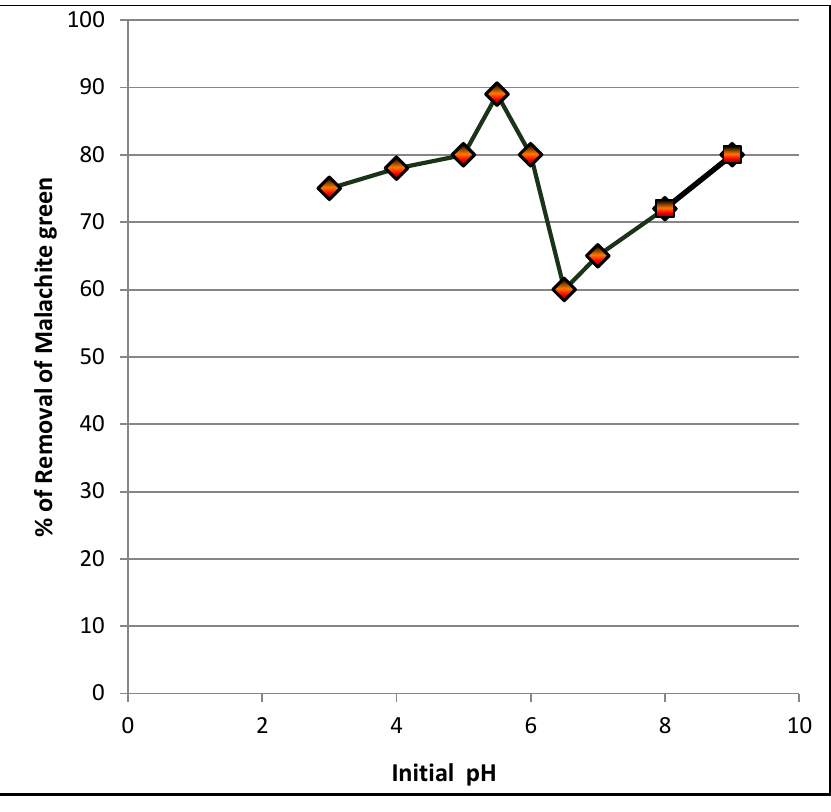
Figure 7. Effect of pH on the adsorption of malachite green onto TPC. [MG]= 100mg/L: adsorbent dose = 25 mg / 50ml: contact time =